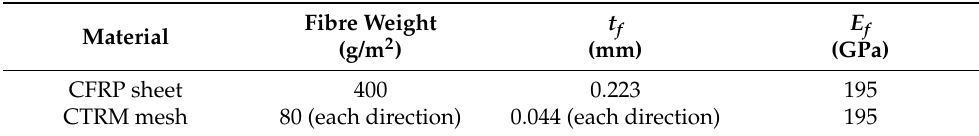
Table 2. Material properties of carbon FRP sheets and textile.